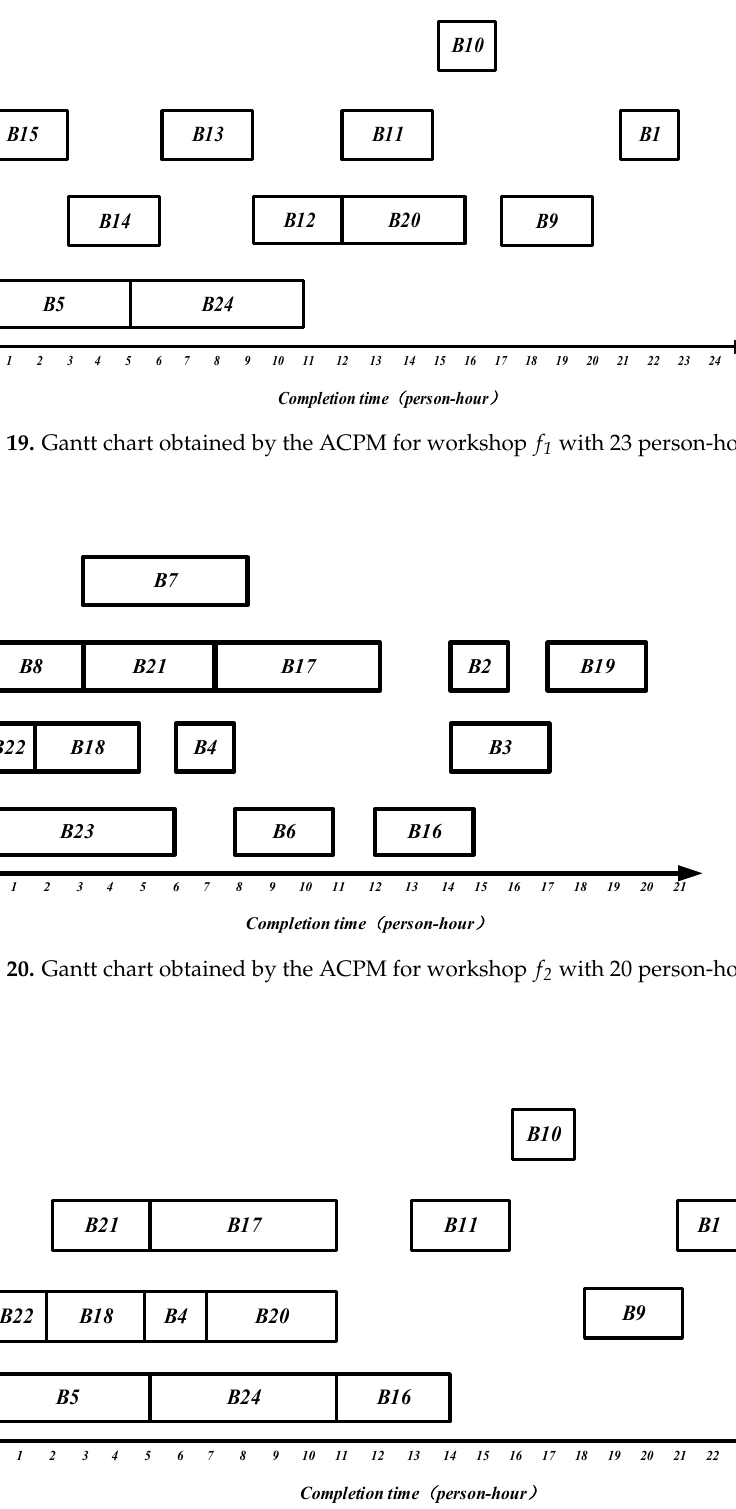
Figure 21. Gantt chart by the NR for workshop f 1 with 23